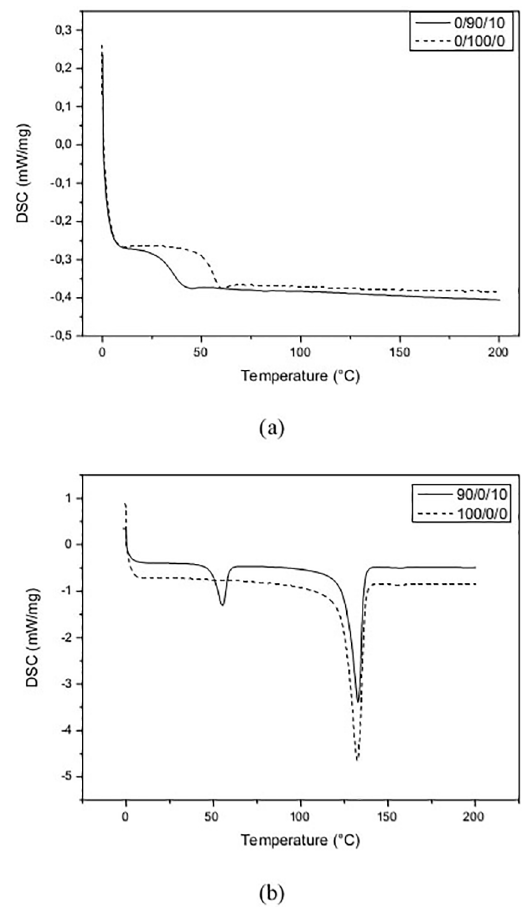
Figure 1. DSC results of (a) epoxy and DGEBA/PE-co-PEG (90/10); (b) HDPE and HDPE/PE-co-PEG (90/10).